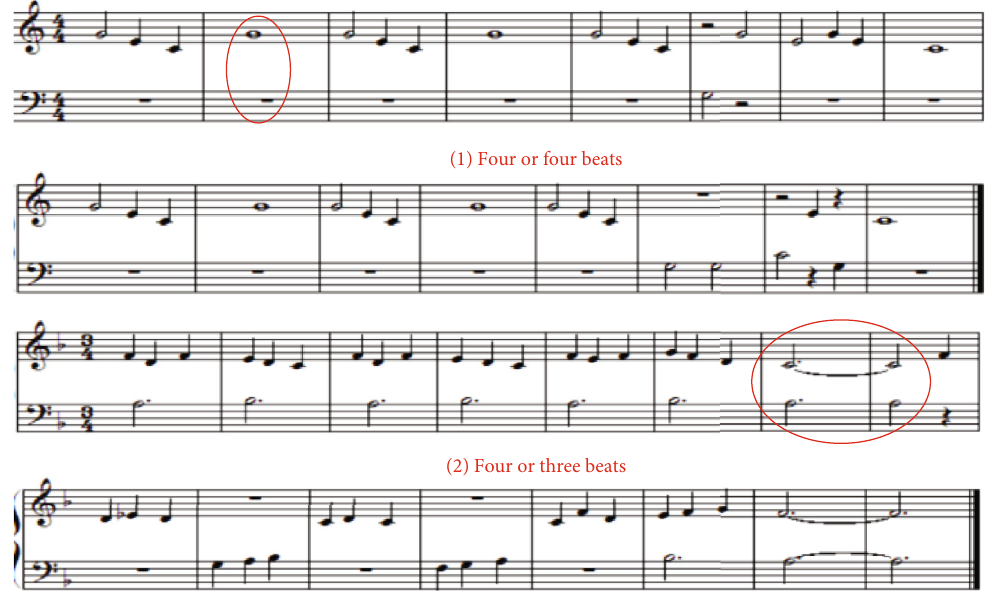
Figure 7: The di ff erence between four or four beats and four or three beats in beat